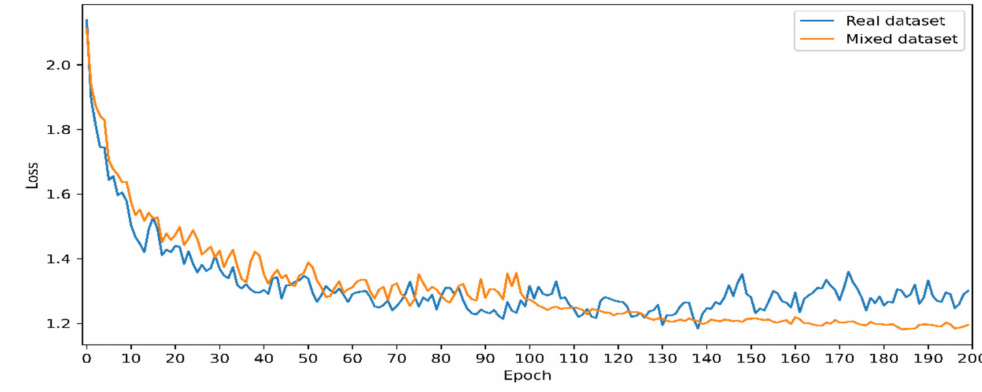
Figure 9. Real and mixed datasets validation losses.